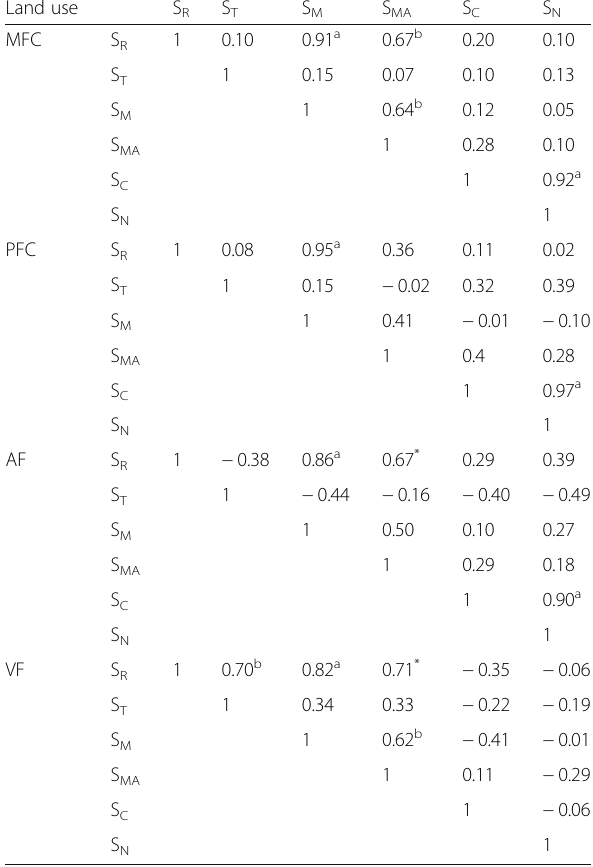
Table 1 Correlation among soil environmental factors and S R in different land uses Land